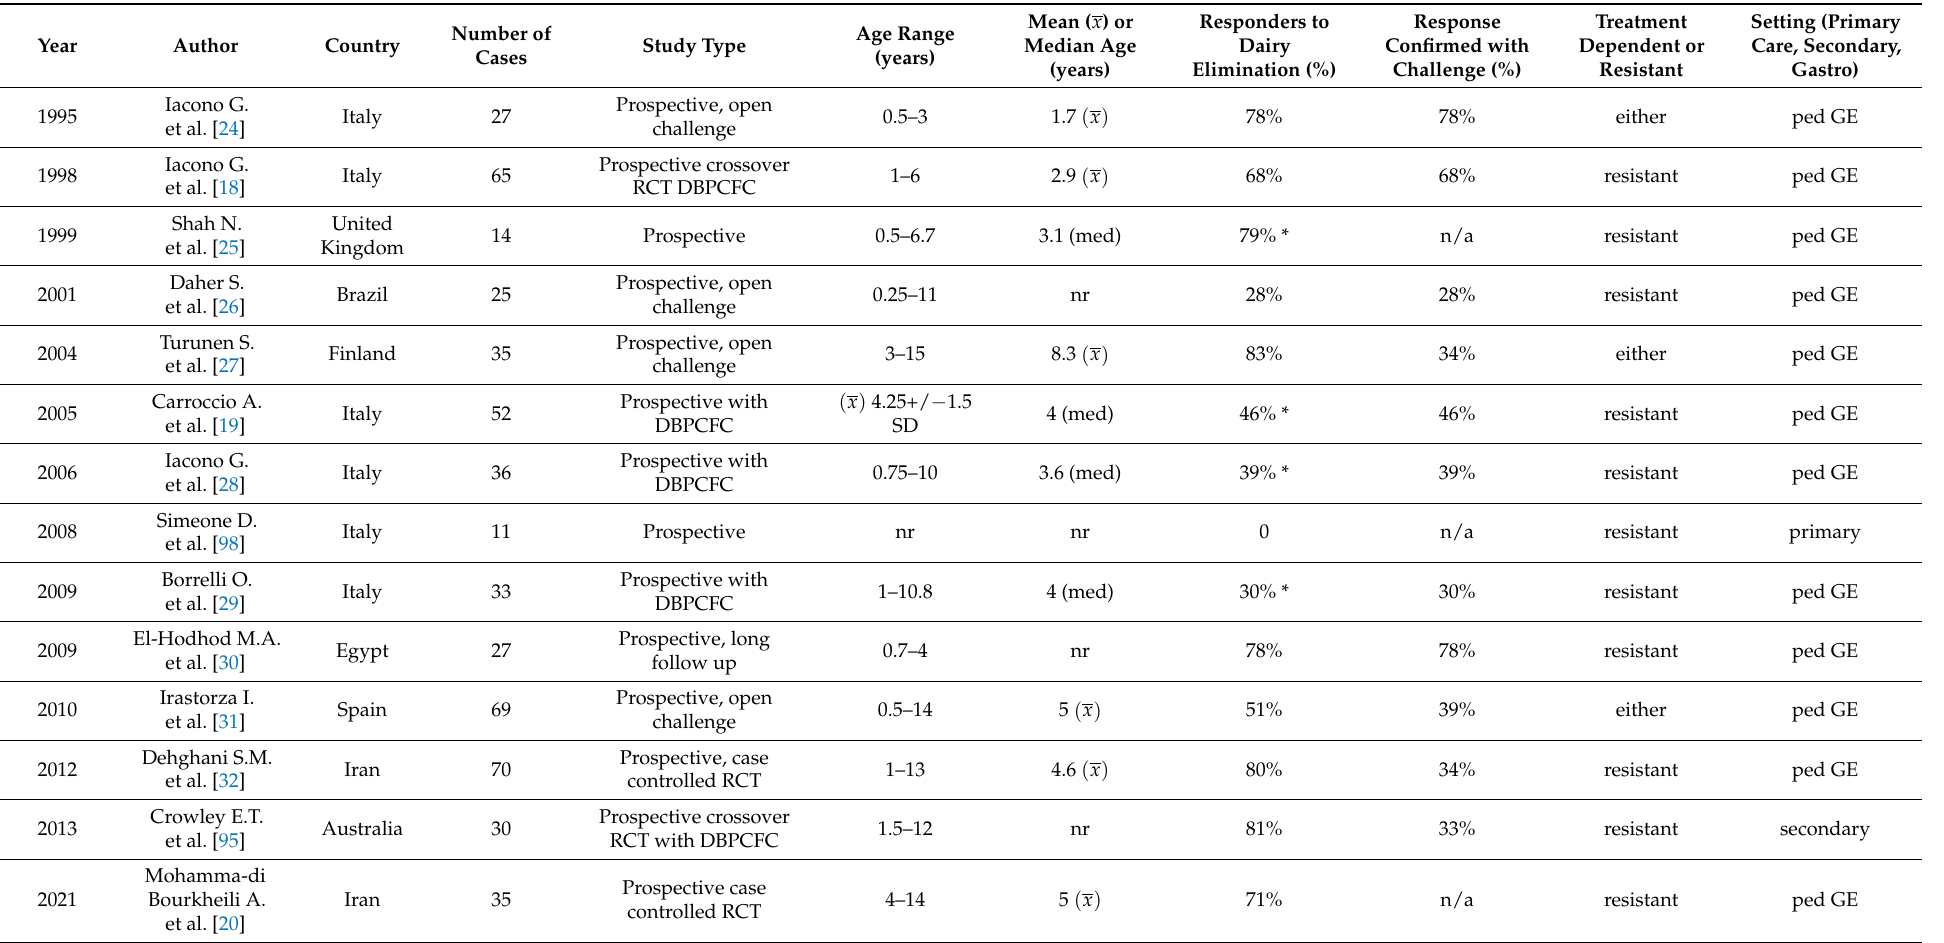
Table 1. Prospective clinical trials of cows’ milk protein elimination diet in childhood constipation. Adapted with permission from ref.